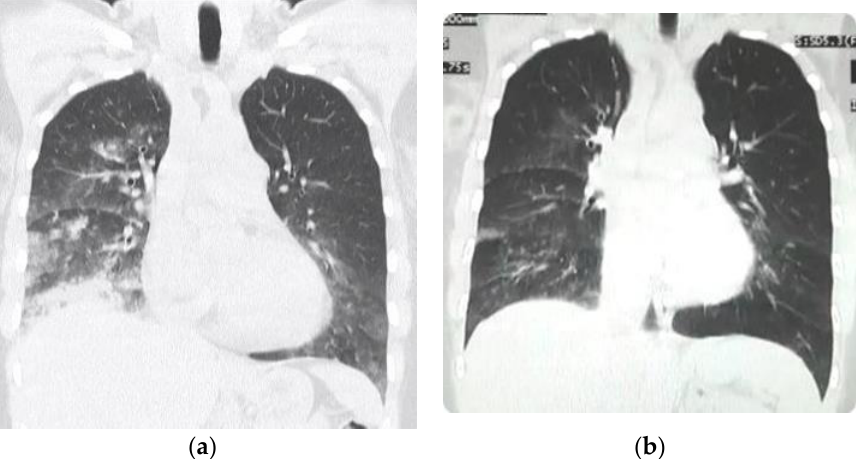
Figure 7. CAT scan of patient with HAPE. ( a ) Note the convex pulmonary arch due to pulmonary hypertension in the acute phase. The heart apex is likewise elevated due to dilatation of the right ventricle. ( b ) In the recovery stage of HAPE (two days later during treatment) a decrease of the pulmonary arch can be observed at closely similar CAT scan coronal cut level (the size of the heart, due to systole or diastole, may have variations).